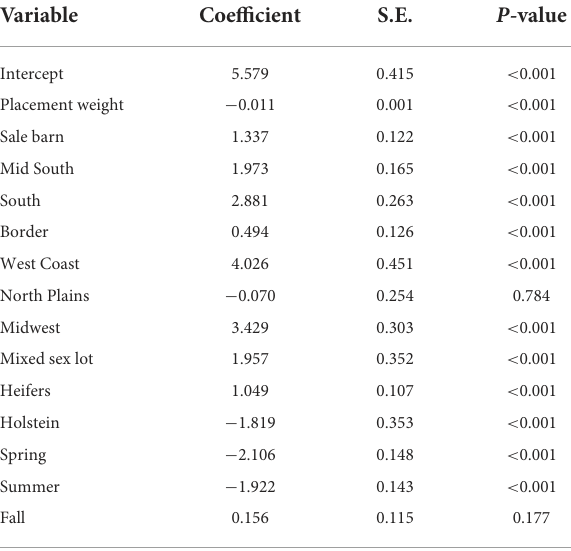
TABLE 3 Parameter estimates of the logit model used to predict whether cattle were given metaphylaxis treatment or not.